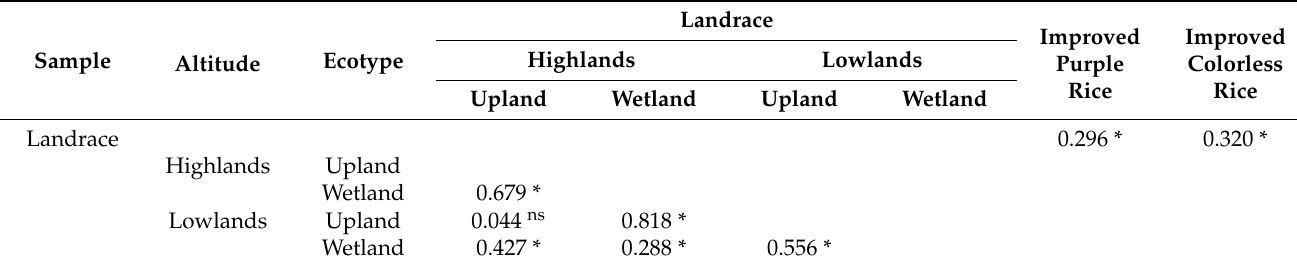
Table 3. Pairwise genetic differentiation (F ST ) among purple rice landrace across different altitudes and ecotypes in northern Thailand and between purple rice landrace and either improved purple rice or colorless varieties.